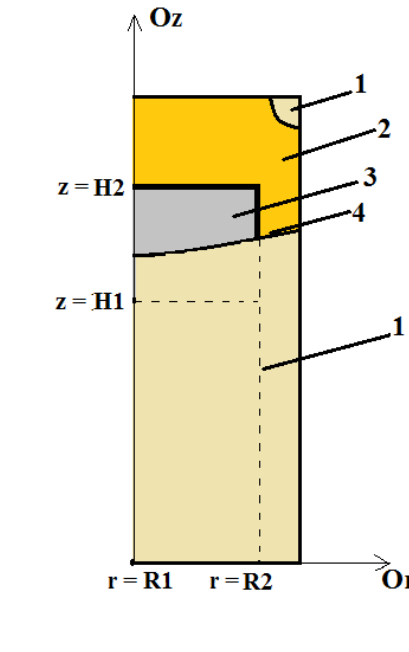
, R ] × [ H , H ] × [ F , F ] ⊆ Ω ; ( b ) D = [ R 1 2 1 2 1 2